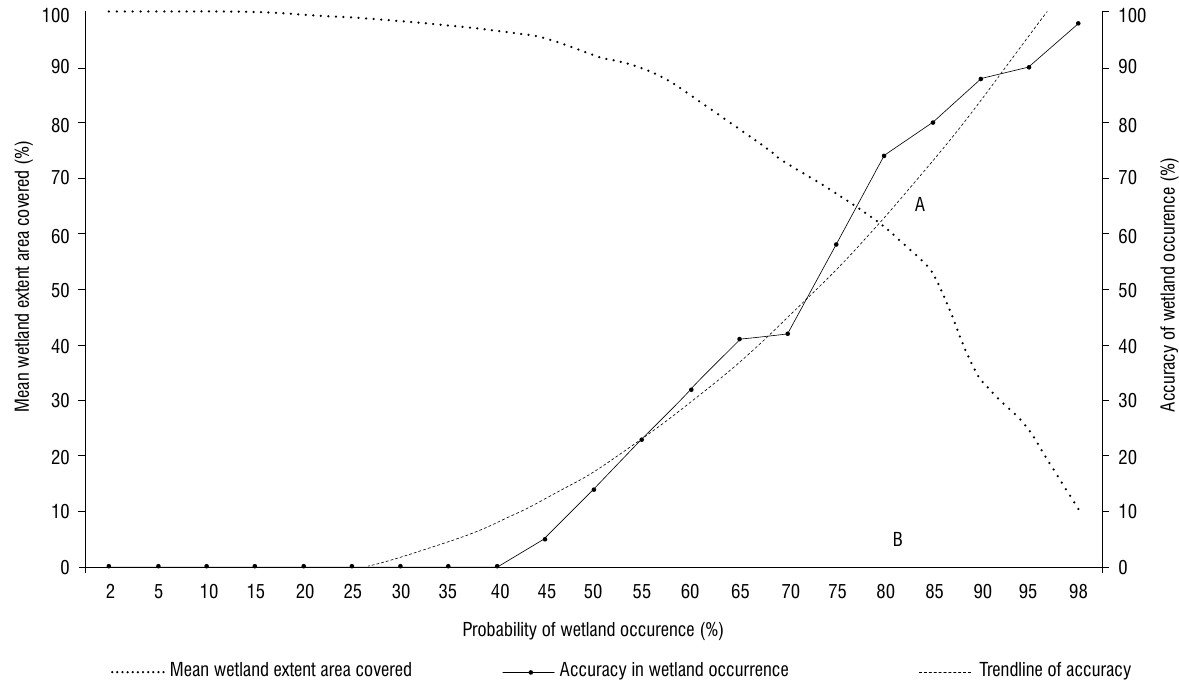
Figure 7: Accuracy in terms of model ability to predict wetland extent and occurrence with the increase in probability percentage. An optimal trade-off value exists at the intersection of extent (A) and accuracy (B) to produce a useable wetland map